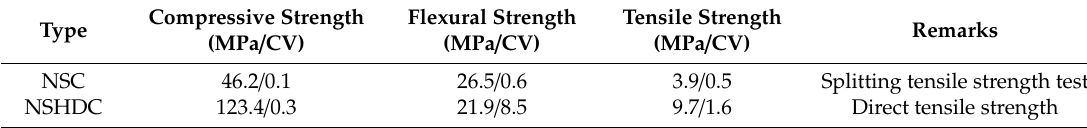
Table 5. Strength test results (28